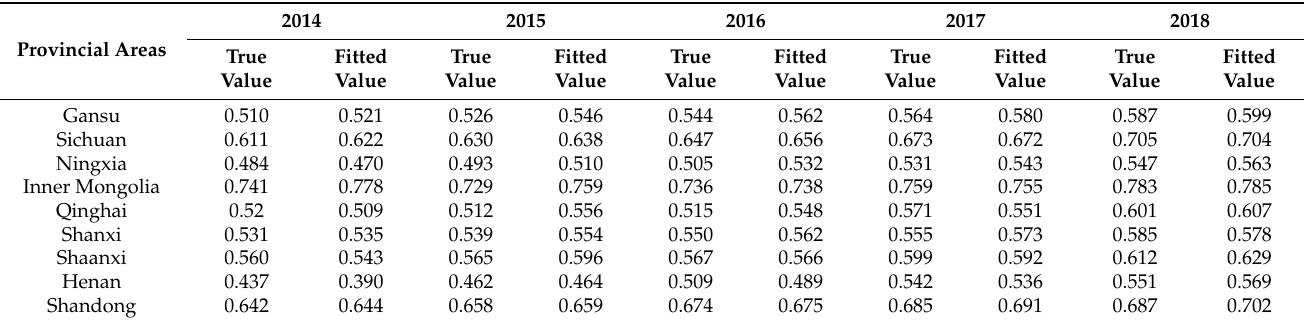
Table 8. Test of coupling coordination degree prediction